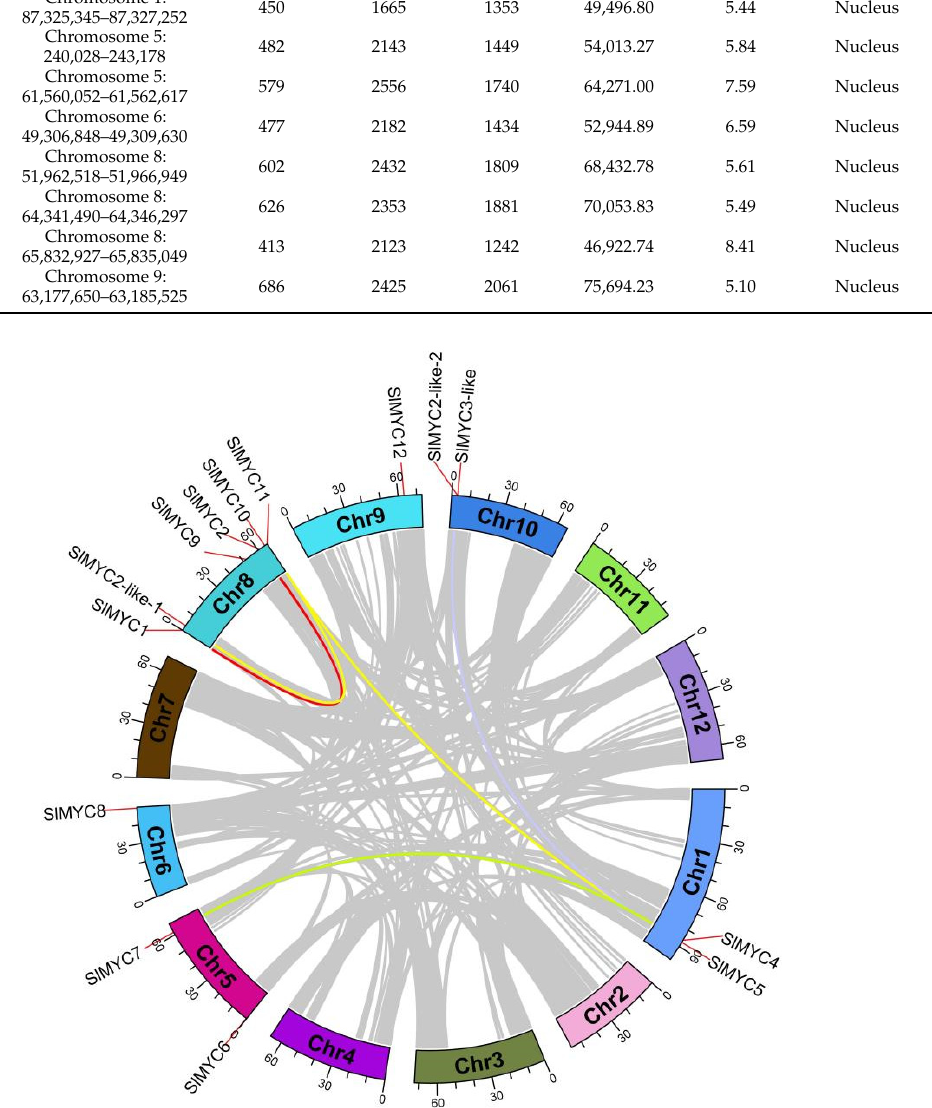
Figure 1. Genome distribution and synteny relationship of SlMYC genes in Solanum lycopersicum . Different chromosomes were used different colors. Colored lines represent the syntenic pairs of SlMYC.